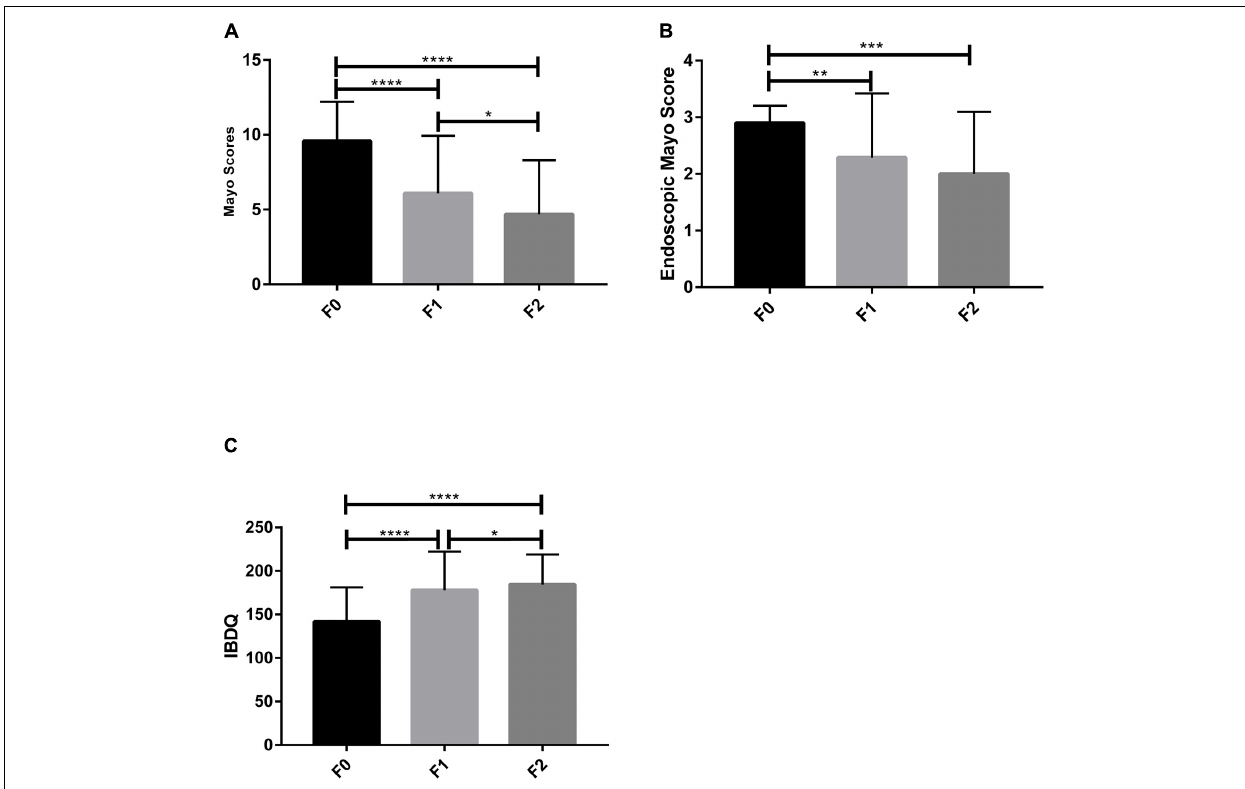
FIGURE 2 | Clinical indexes of patients. (A) Mayo score, (B) Endoscopic Mayo score, and (C) IBDQ score were measured to evaluate the FMT therapeutic outcomes. F0, before FMT; F1, 2 ∼ 3 months after the first FMT, or before the second FMT; F2, 2 ∼ 3 months after the second FMT. * p < 0.05, ** p < 0.01, *** p < 0.001, **** p < 0.0001 (Paired t -test with GraphPad Prism 7.00).